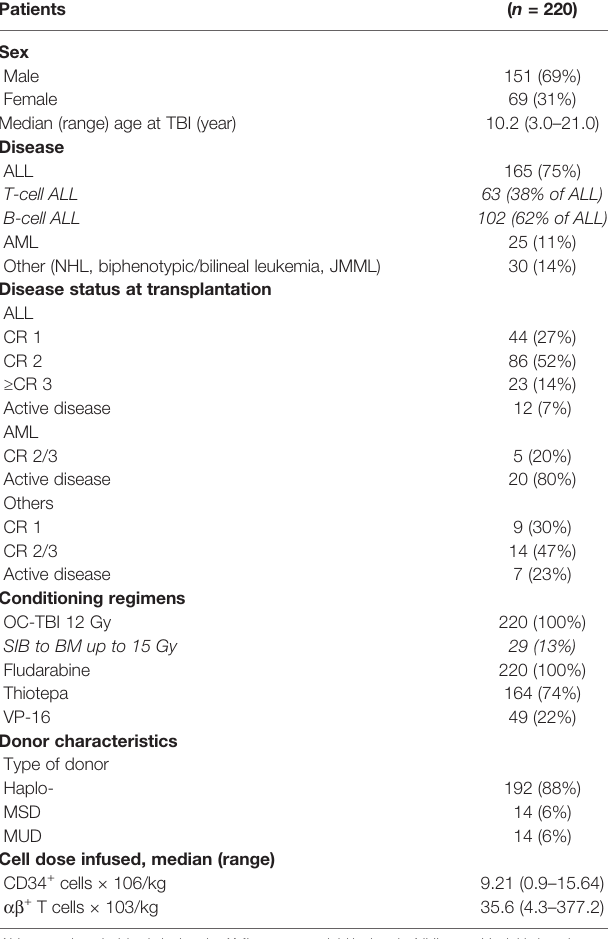
TABLE 1 | Patient and treatment characteristics.